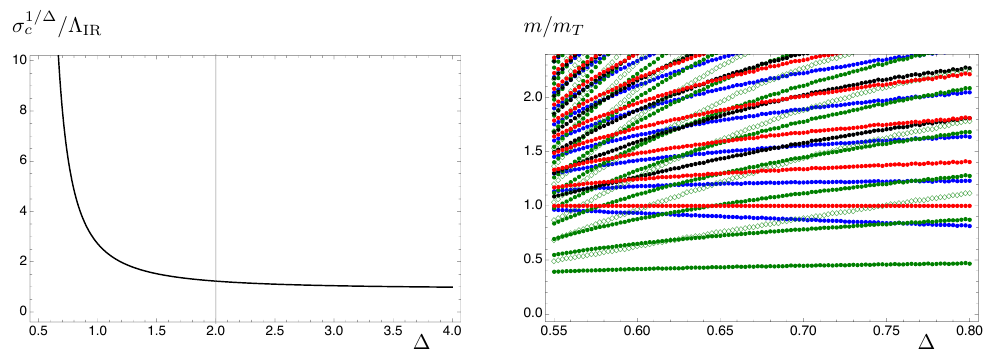
Figure 7 . Example B. The left panel shows the dimensionless ratio σ 1 / ∆ c / Λ IR . The right panel shows the spectrum as a function of ∆ (close to ∆ ’ 1 to the mass m of the lightest T